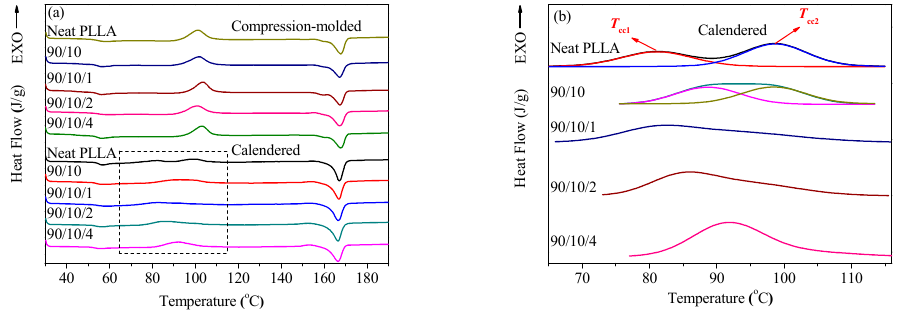
Figure 5. ( a ) DSC traces of PLLA and PLLA/EPDM/OMMT (90/10/ x ) samples prepared by compression-molding and calendering, and ( b ) DSC thermograms of calendered samples in the temperature range of 65–115 ° C.